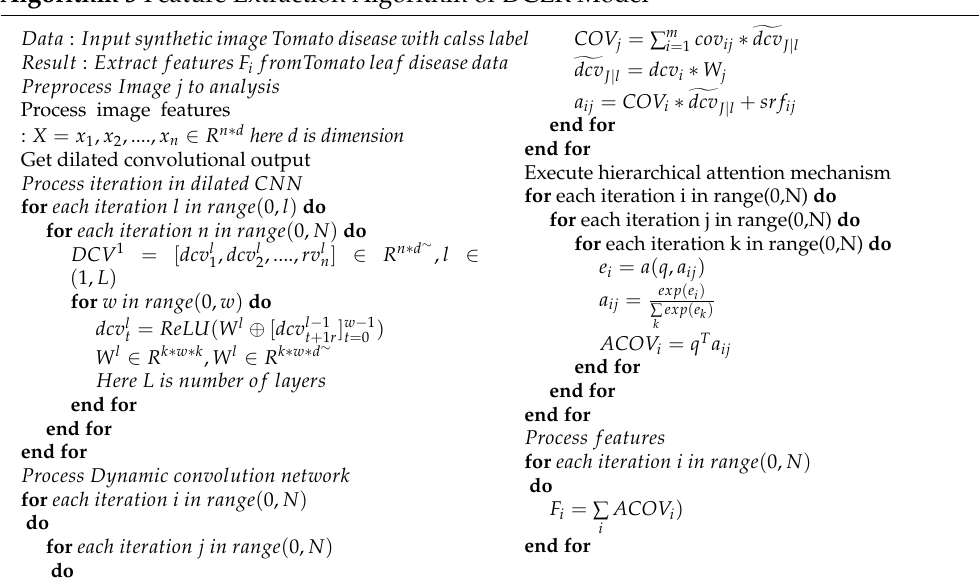
Algorithm 3 Feature Extraction Algorithm of DCLR Model